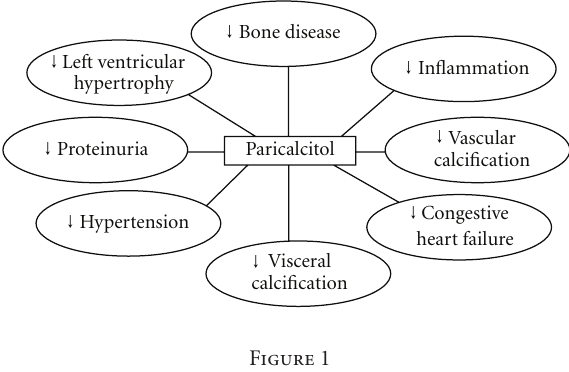
proteins (e.g., calbindin, CAT, and PMAT) compared to calcitriol, [36, 37] thus conferring a selective activator function